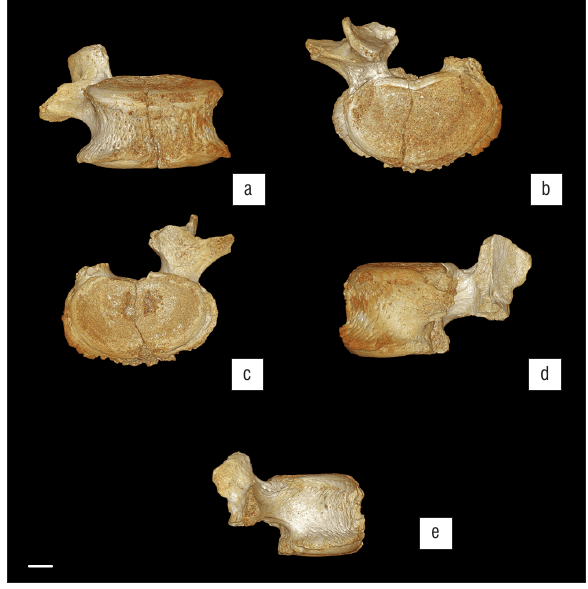
Figure 2: Three-dimensional volume rendered micro-CT views of the L4 vertebra of StW 431: (a) anterior, (b) superior, (c) inferior, (d) left lateral and (e) right lateral. Slight osteophytic lipping occurs around the antero-superior region of L4, which creates a rolled appearance to the margin of the labrum, which is further disturbed by the erosion of this surface (Figure